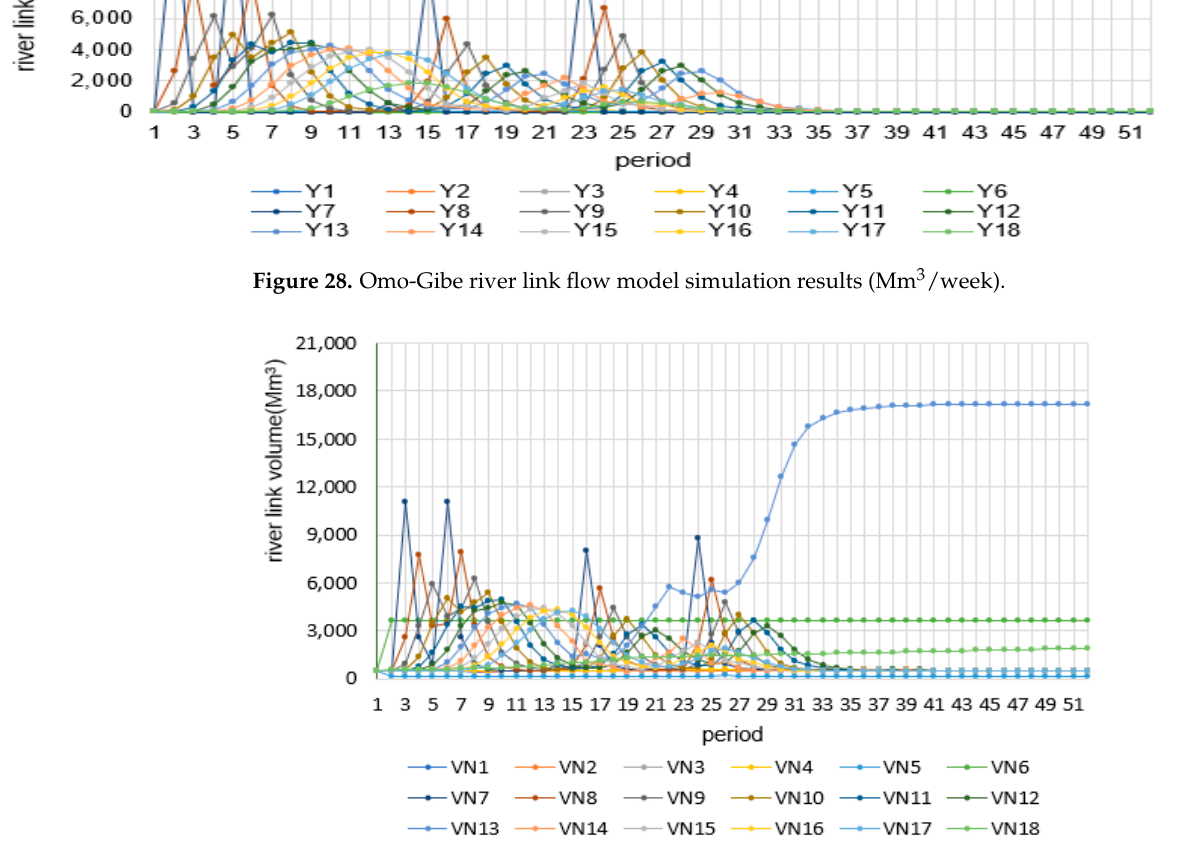
Figure 29. Omo-Gibe river volume model simulation results.